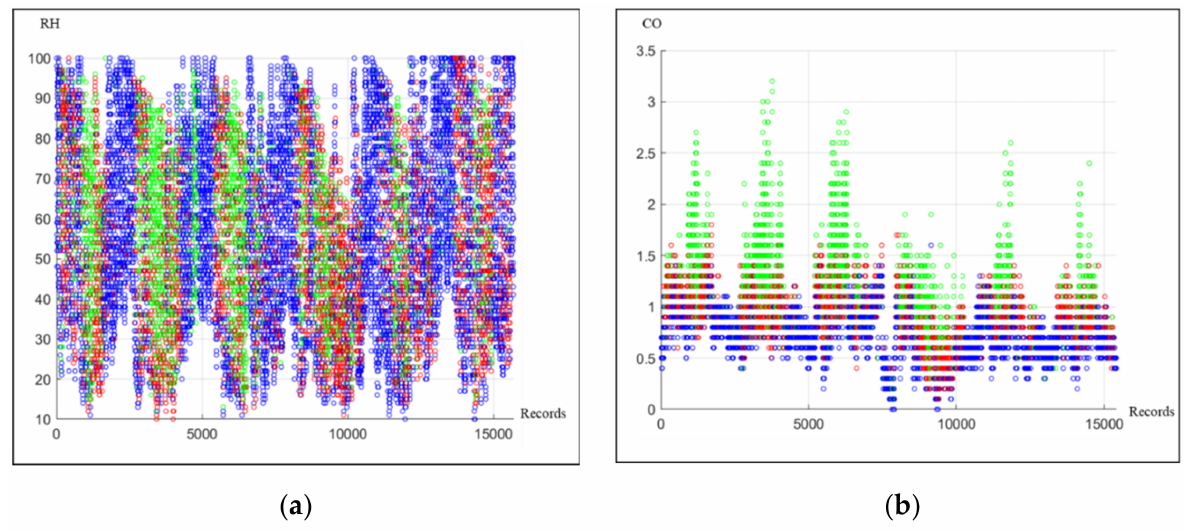
Figure 2. Scatter plot with three classes of PM 10 in the LPA-Met station: ( a ) RH and ( b )